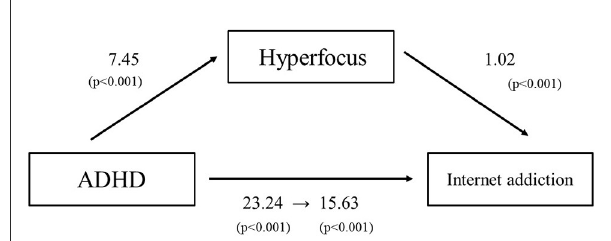
FIGURE1 A mediation analysis was used to examine whether hyperfocus mediates the relationship between ADHD and IA tendencies. To examine the relationship between ADHD tendency and IA (c), regression analysis was performed and a positive correlation was found ( c = 23.24, p < 0.001). Regression analysis was then conducted to examine the relationship between ADHD tendency and hyperfocus intensity (a), and there was a positive correlation ( a = 7.45, p < 0.001). Finally, multiple regression analysis was